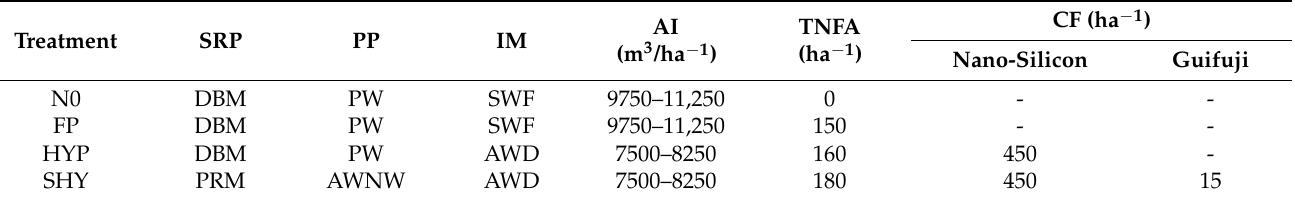
SRP: seedling-raising patterns; PP: planting patters; IM: irrigation methods; AI: amount of irrigation; TNFA: total N fertilizer application; CF: compound fertilizer; N0: no nitrogen application; FP: local farmer practice; HYP: high-yield, high-efficiency practice; SHY: super-high-yield practice; DBM: dry bed method; PRM: potted raising method; PW: parallel row; AWNW: alternating wide and narrow rows; SWF: shallow water flood irrigation; AWD: alternate wetting and drying irrigation.